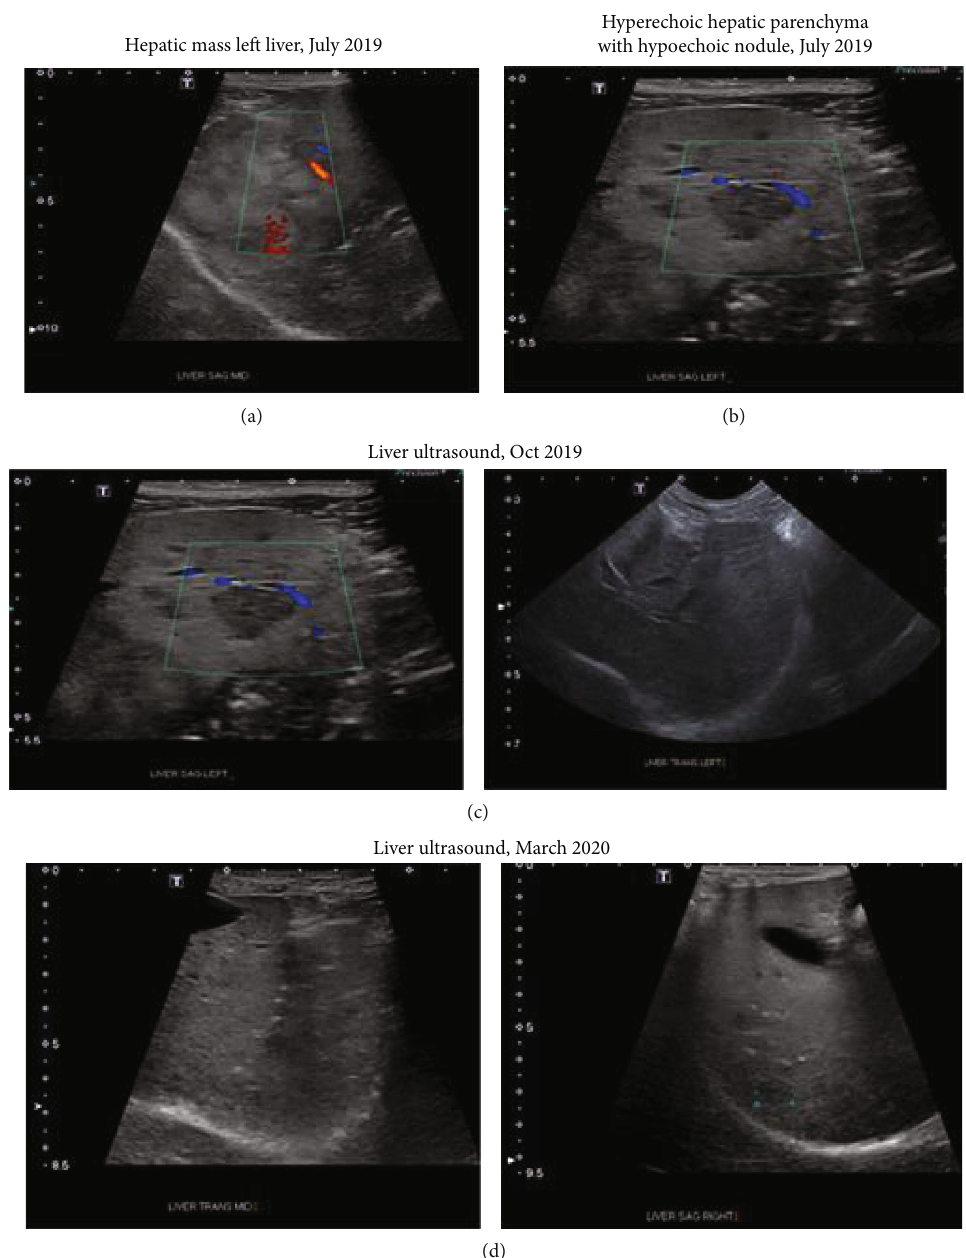
Figure 2: Ultrasound images of Subject One with hepatocellular carcinoma. (a, b) Presurgical images of liver tumor. (c) 3-month image posttreatment of the resected area. (d) 7-month image posttreatment of the resected area. No signs of tumor regrowth or metastases were